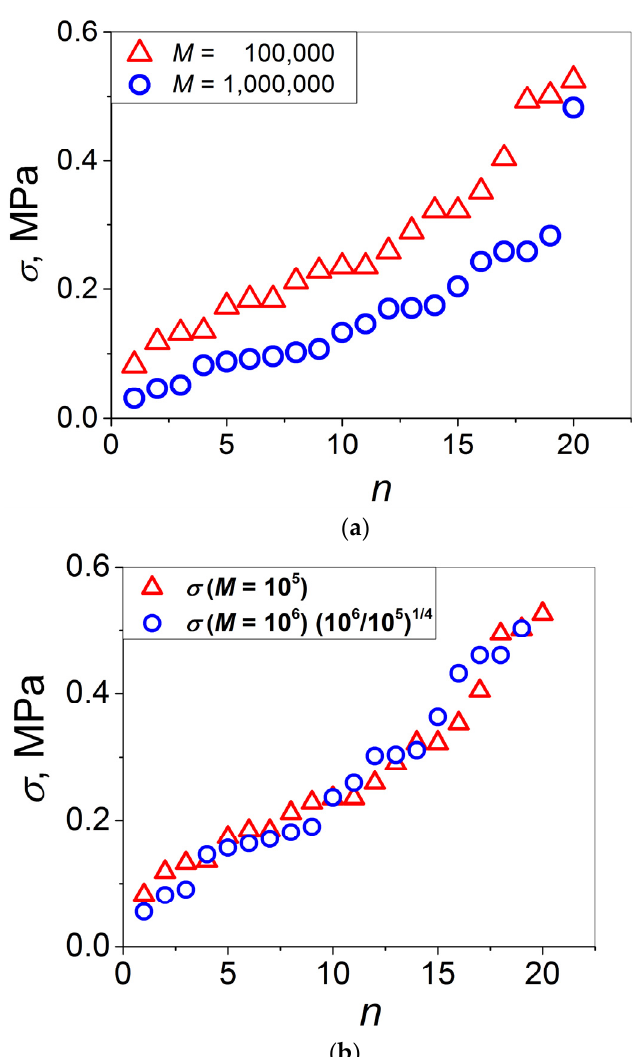
Figure 2. ( a ) Lap-shear strength σ ascending order as a function of joint number developed at symmetric PS–PS interfaces with (open triangles) M = 10 5 and (open circles) M = 10 6 ; ( b ) data of Figure 2a where the σ values for PS2 with M = 10 6 are reduced to the σ values for PS1 with M = 10 5 by the multiplication of the formers by (965,600/97,000) 1/4 (see text).